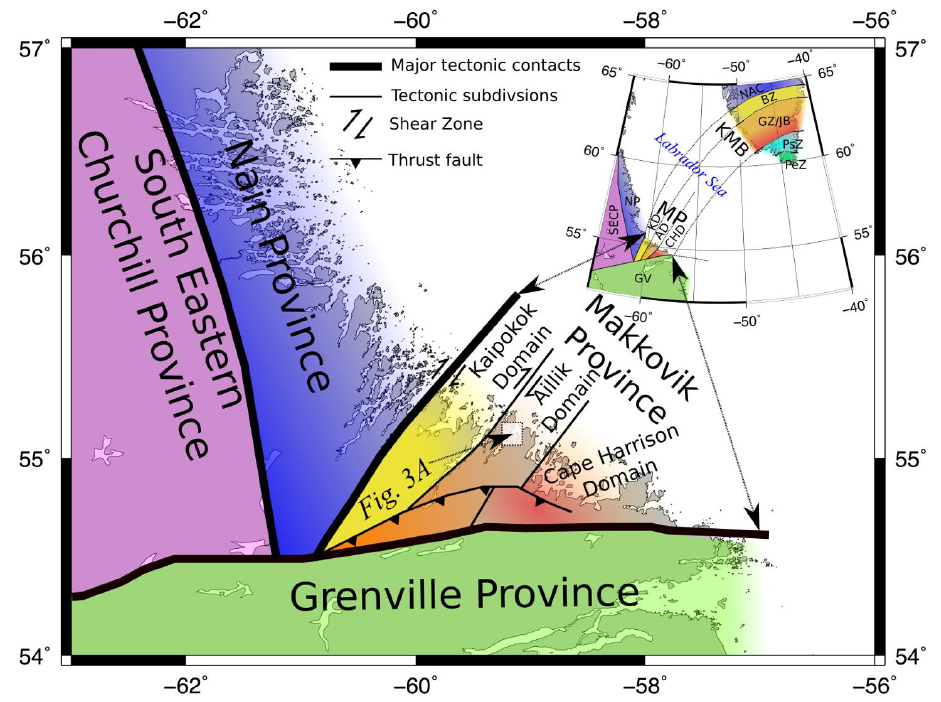
Figure 2. Simplified tectonic framework of central Labrador modified from [22] based on [23], including the location of Figure 3A within the Makkovik Province. Abbreviations: NAC, North Atlantic Craton; BZ, Border Zone; GZ/JB, Granite Zone/ Julianehåb Batholith; NP, Nain Province; MP, Makkovik Province; PsZ, Psammite Zone; PeZ, Pelite Zone; SECP, southeastern Churchill Province; KD, Kaipokok Domain; AD, Aillik Domain; GV, Grenville Province; KMB, Ketilidian Mobile Belt. Inset: The correlation of the Makkovik and Ketilidian orogenic belts has been modified from [24].